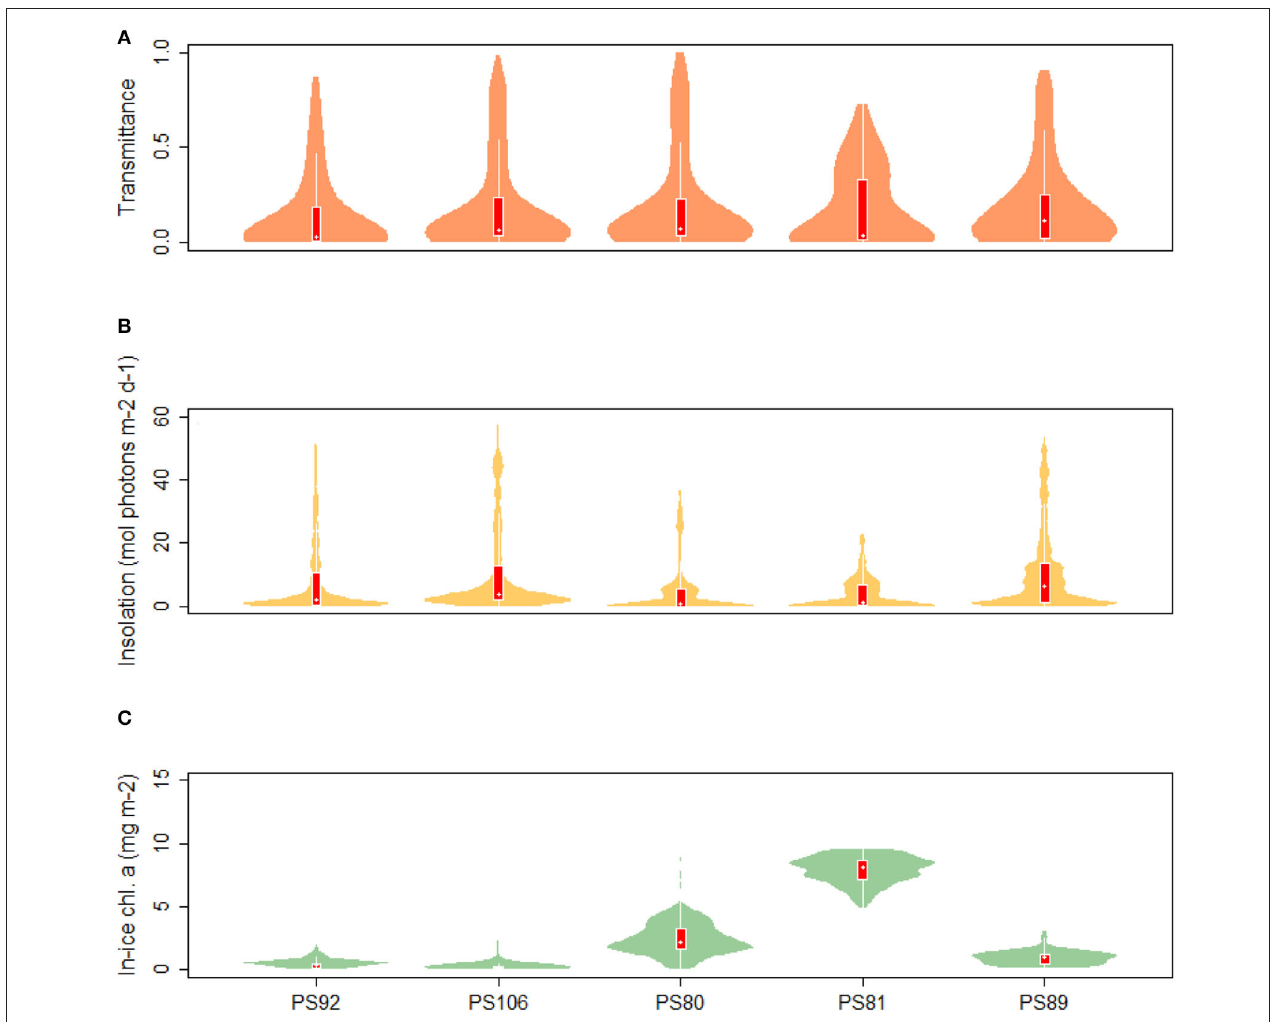
FIGURE 7 | Violin plots of (A) transmittance, (B) insolation, and (C) chl a concentration in sea ice. The “violins” show density functions of the relative frequency distribution of the data. Superimposed on the violin plots are box plots showing the median (white dot), the 1st to 3rd quartile range (red boxes), and the lowest and highest data points within approximate 1.5 times the interquartile range (white lines extending from the